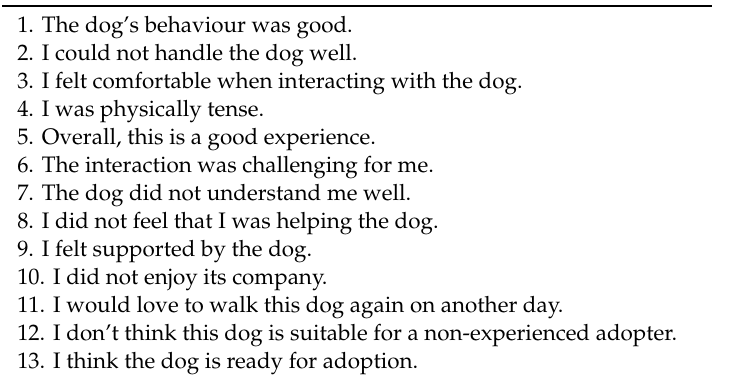
Table 1. Exit questionnaire for volunteers ( n = 74) following walking dogs ( n = 111) on a designated route at Royal Society for the Prevention of Cruelty to Animals (RSPCA) Queensland, requiring them to rate each sentence on a 5-point scale from 1 (strongly disagree) to 5 (strongly agree).